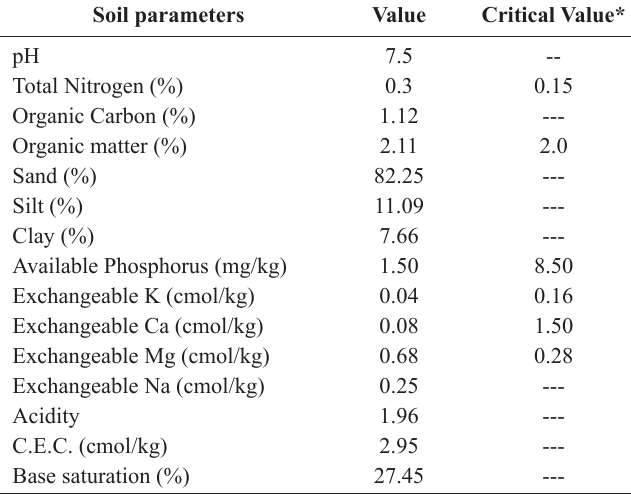
Table 1: Analysis of the experimental field soil.